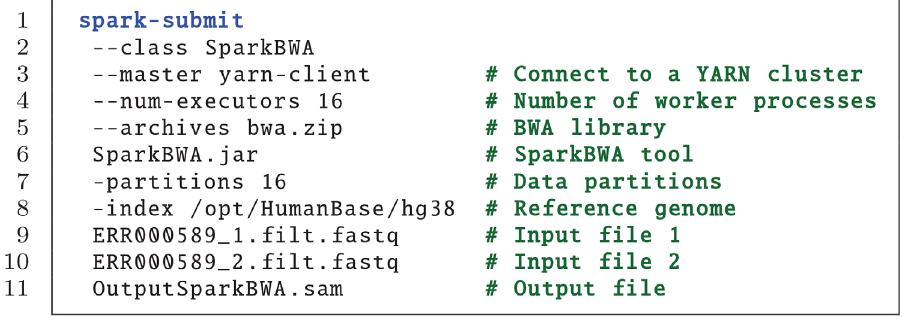
Fig 4. Example running SparkBWA from the